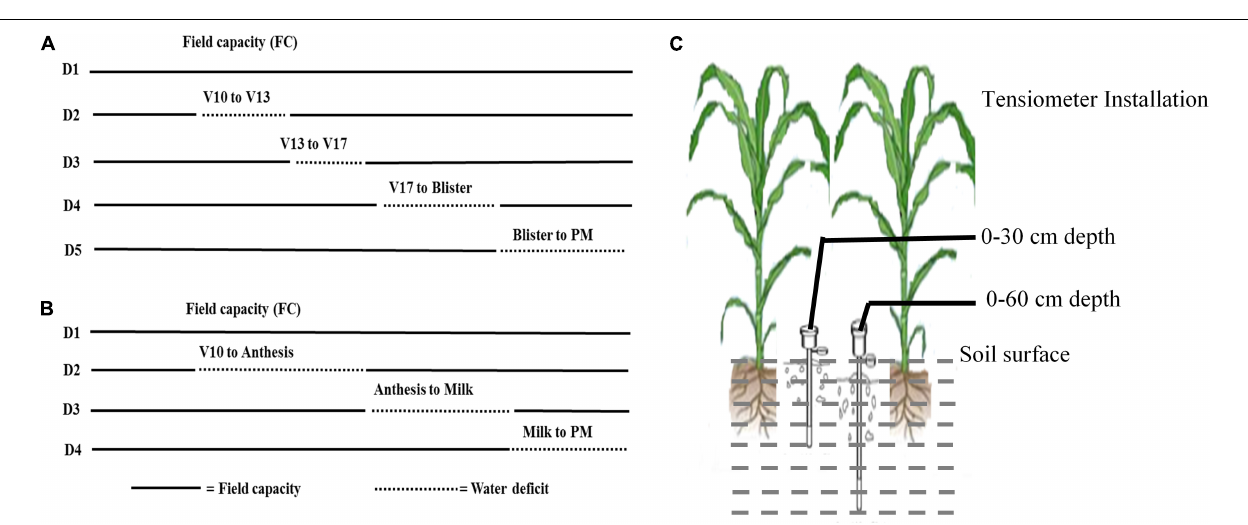
FIGURE 1 | Maize growth stage from emergence to maturity. VE About 4–5 days after planting under ideal conditions, but up to 2 weeks or longer under cool or dry conditions. V1–V5 At V1, round-tipped leaf on first collar appears, nodal roots elongate. By V2, plant is 2–4 inches tall and relies on the energy in the kernel. V3 begins 2–4 weeks after VE and V5, the number of potential number of leaf and ears are determined. V6–V8 Beginning 4–6 weeks after VE. V9–V11 Around 6–8 weeks after VE. V12–Vnth By V12, the plant is about 4 feet tall or more. VT Beginning around 9–10 weeks after emergence. R Corn plants enter reproductive growth after completing tassel emergence, although reproductive stages are determined by kernel development, instead of plant collars. R6 Black Layer Attained about 60 days after silking stage.